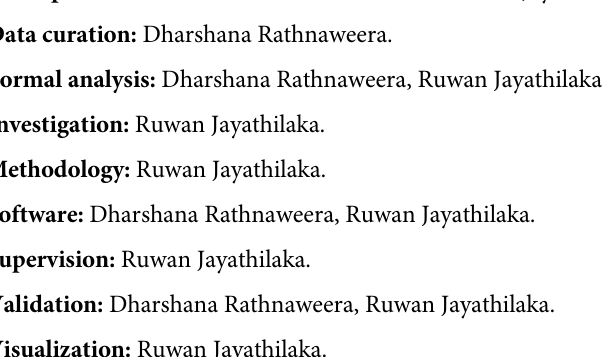
S3 Appendix. Coefficients table and model summary for model